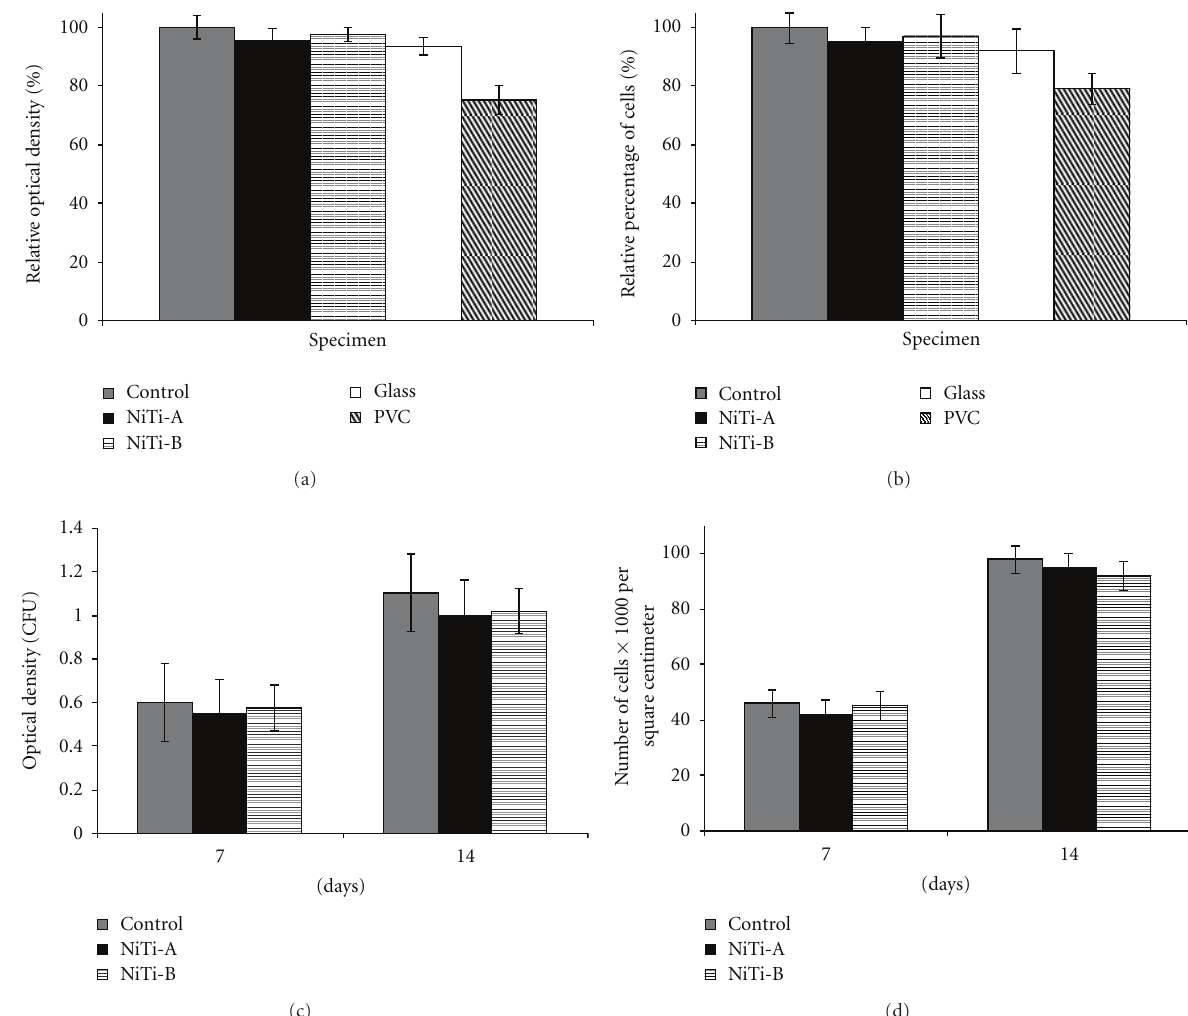
Figure 7: Cytotoxicity of the NiTi-A and NiTi-B specimens: MTS assay (a) and cell counting in the Goryaev chamber (b); e ffi ciency of MSC proliferation with the NiTi-A and NiTi-B specimens: MTT test (c) and cell counting in the Goryaev chamber